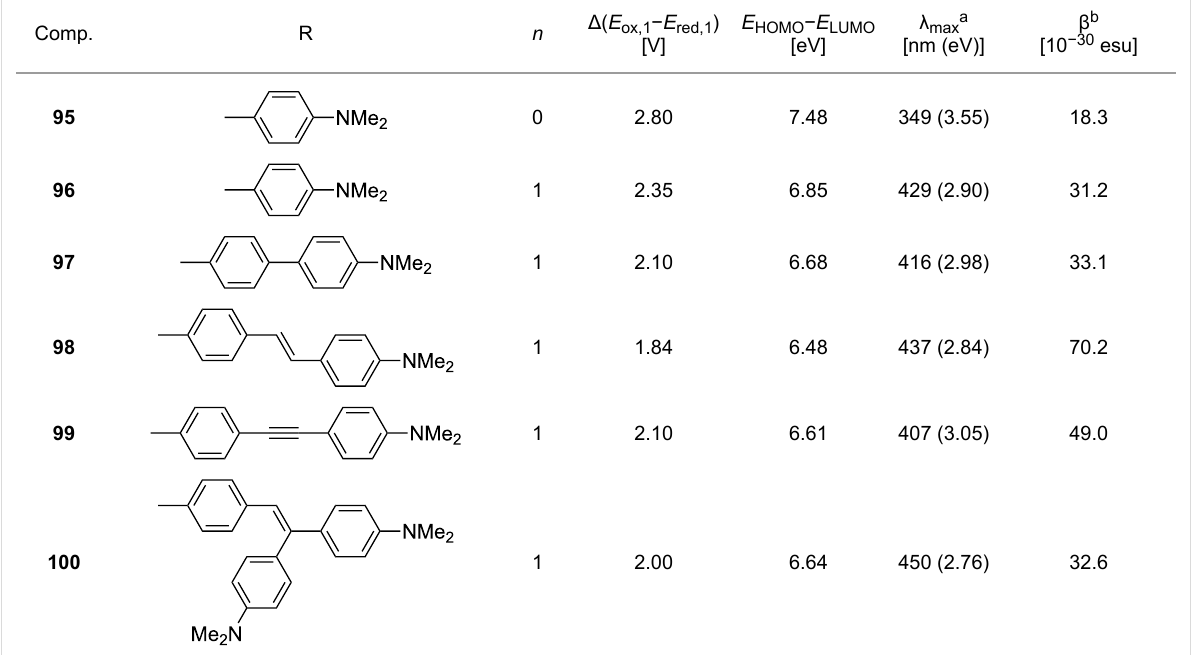
Table 12: Structures and selected properties of branched chromophores [112].